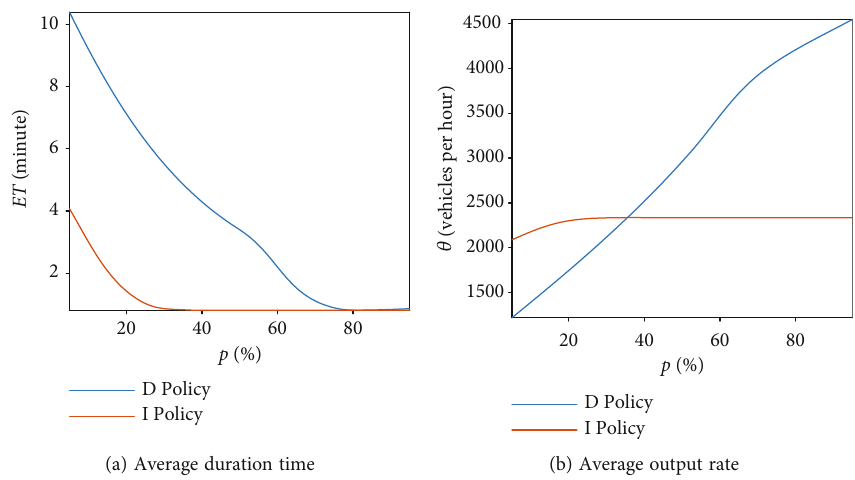
Figure 7: Comparison between the D policy and the I policy when SCV = 0 : 4 under a low tra ffi c intensity.